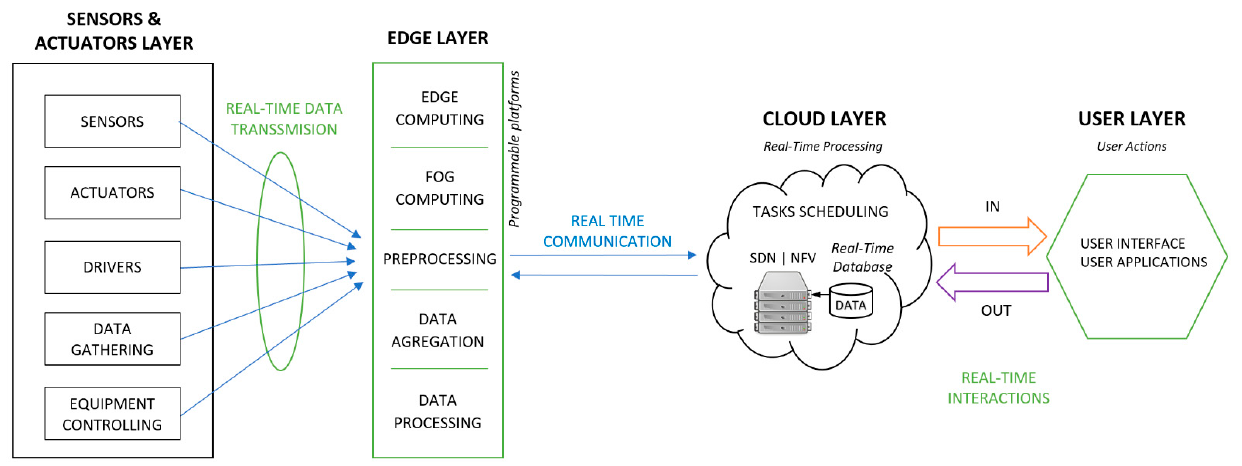
Figure 2. General architecture of a real-time IoT system.